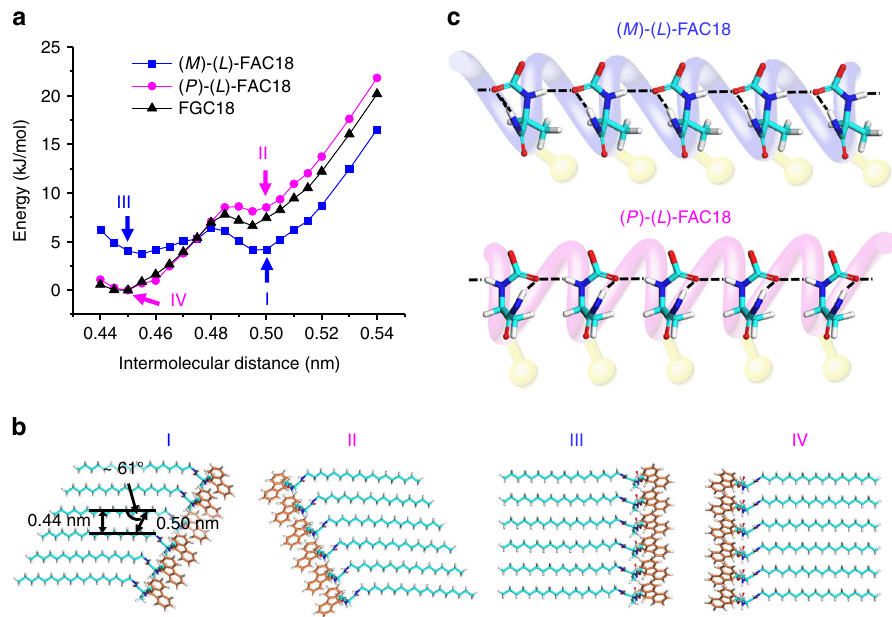
Fig. 3 Competing aggregation pathways. a Energy pro fi les of the 1D arrays of FGC18 and P - and M -forms of ( L )-FAC18, as a function of the intermolecular distance. The energy minimum of ( L )-FAC18 and FGC18 arrays are set to zero for comparison. b Four supramolecular organizations along the energy pro fi les of ( L )-FAC18, corresponding to 1D slanting arrays of (I) M - and (II) P -conformer with a intermolecular distance of 0.50 nm, and 1D near-rectangular arrays (III) M - and (IV) P -conformer with a regular spacing of 0.45nm. The intermolecular distance (0.50 nm), the spacing between alkyl chains ( ∼ 0.44 nm) and the oblique angle ( ∼ 61°) of organization I are indicated. The fl uorene group of ( L )-FAC18 is displayed in orange for clarity. I – IV of ( D )-FAC18 and FGC18 are de fi ned in the same way and displayed in Supplementary Fig. 4. c Illustration and “ helix ” representation of 1D alignment of M - and P -forms of ( L )-FAC18. The intermolecular and intramolecular hydrogen bonding are indicated by dashed